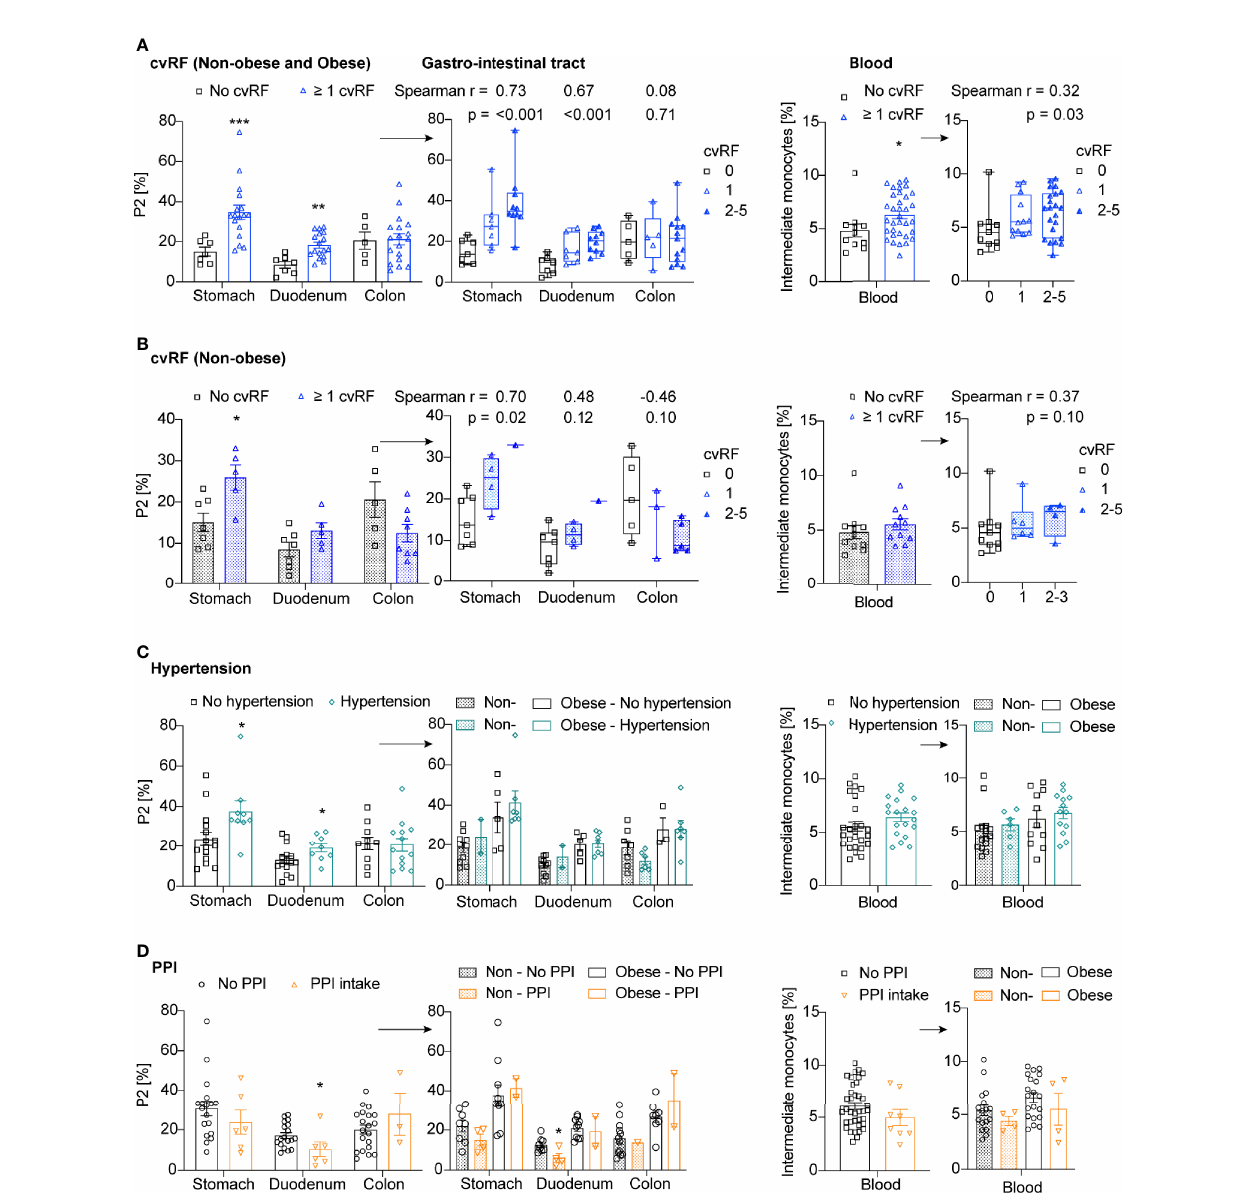
FIGURE 5 | Cardiovascular risk factors other than obesity do not affect intestinal macrophage subpopulation P2 and intermediate blood monocytes. (A – D) Frequency of P2 intestinal macrophages in the stomach, duodenum, or colon transversum, and intermediate blood monocytes in patients with or without cardiovascular risk factors (cvRF) (blue) ( A : Non-obese and obese patients, B : only non-obese patients), hypertension (green) (C) , and PPI intake (orange) (D) . The right panels are additionally strati fi ed by the number of cvRFs (0, 1, >2) (A, B) or by the non-obese or obese body habitus (C, D) . One data point represents one subject. Statistical data are expressed as mean ± SEM. * p <0.05. ** p <0.01, *** p <0.001, unpaired Mann-Whitney U test with two tailed distribution. For Spearman correlation analysis, p -values < 0.05 were considered signi fi